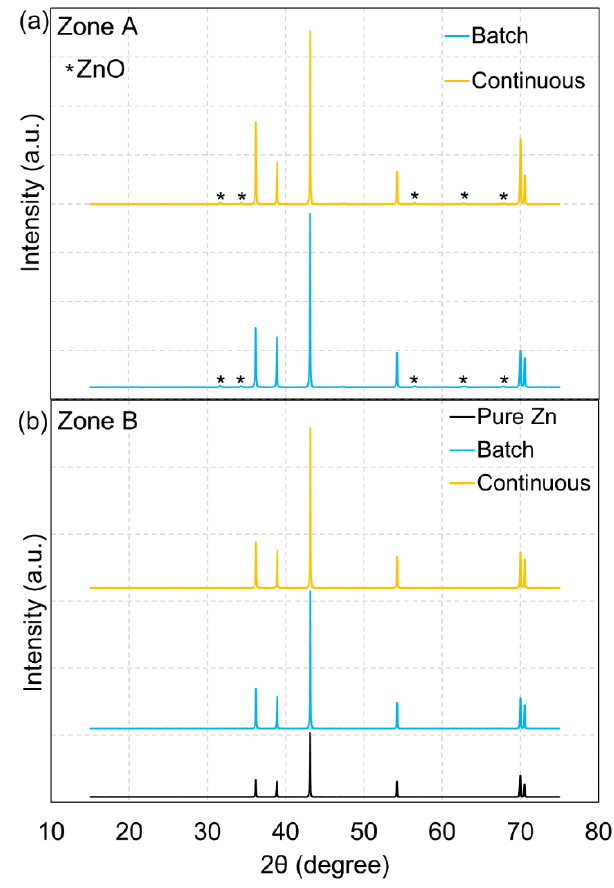
Figure 9. XRD patterns of the collected Zn products in batch and continuous modes: ( a ) zone A and ( b ) zone B. Source: author.